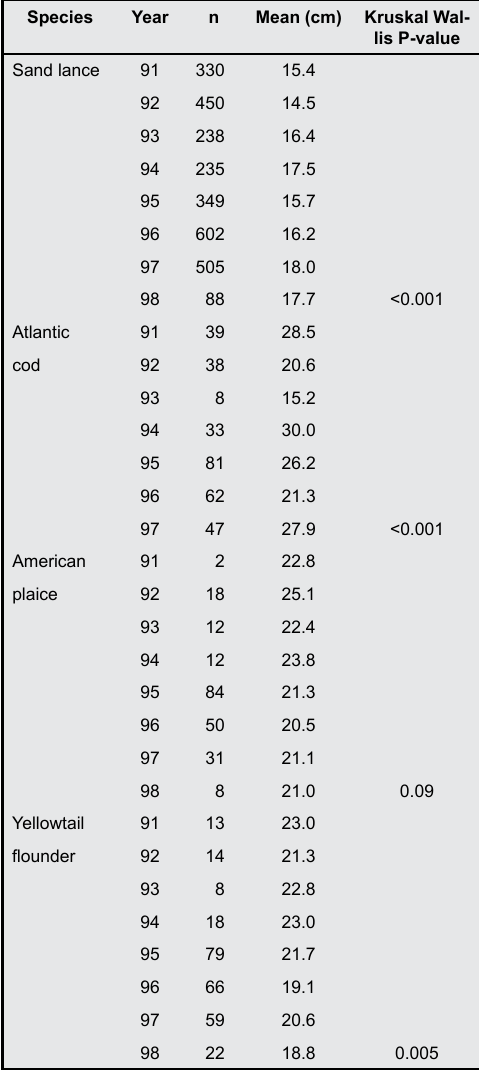
Table 5 . Interanual variation in measured prey lengths for 4 species in the grey seal diet, all years combined. (Scientific names in